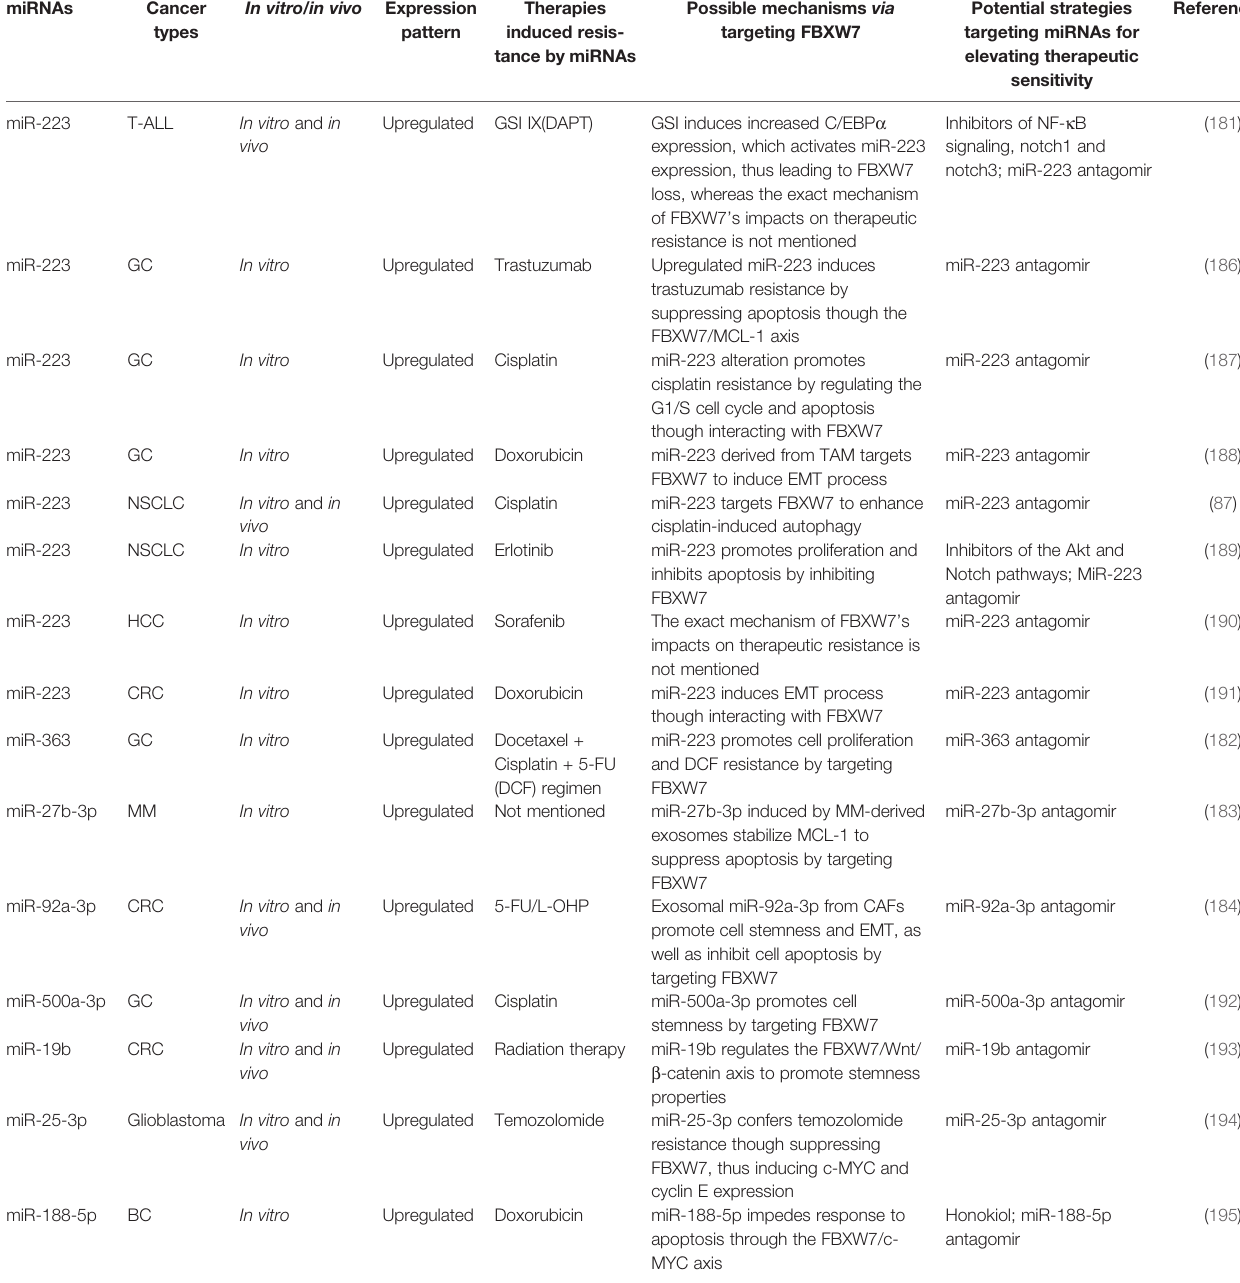
TABLE 1 | MicroRNAs regulate therapeutic resistance via targeting FBXW7 and the possible